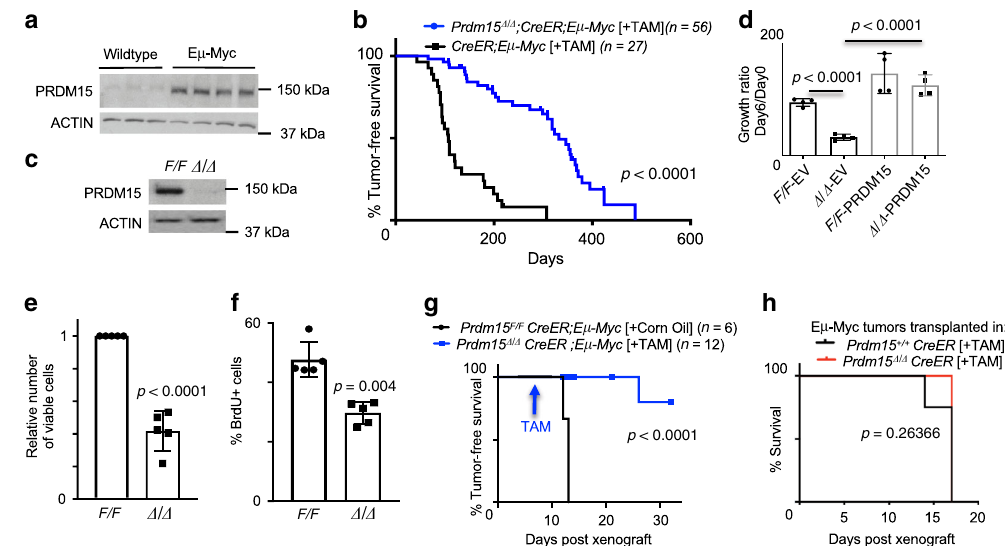
Fig. 3 PRDM15 is critical for lymphoma initiation and maintenance in E µ -Myc mice. a PRDM15 protein expression in bone marrow-derived B cells from wildtype ( n = 3) and E µ -Myc ( n = 4) mice. b Disease-free survival of R26; E µ -Myc or Prdm15 F/F ; R26; E µ -Myc mice injected with TAM at 5 weeks of age. c Western blot validation of complete PRDM15 protein depletion upon addition of 4-OHT (OHT) to Prdm15 F/F Rosa26Cre-ERT2 tumor cells cultured in vitro; data are from a representative experiment ( n = 20). d Growth ratio of Prdm15 F/F ;R26; E µ -Myc vs. Prdm15 Δ / Δ ;R26; E µ -Myc cells on day 6 post seeding. Cells were treated with 4-OHT (OHT) overnight (day − 1) to induce PRDM15 deletion ( Δ / Δ ). Prior to the addition of OHT, cells were transfected either with empty vector control (EV) or a vector expressing PRMD15 as indicated. Data are from two independent cell cultures, with two technical replicates each. Center values mean; error bars, s.d. e Relative number of viable E µ -Myc cells following PRDM15 depletion by OHT. f Relative % of Brdu + E µ -Myc cells upon EtOH ( Prdm15 F/F ) vs. OHT ( Prdm15 Δ / Δ ) treatment. In e and f , data are from independent primary lines ( n = 5). Center values, mean; error bars, s.d. g Overall tumor-free survival of mice transplanted with Prdm15 F/F ;CreER; E µ -Myc lymphoma cells, then injected with corn oil or TAM 1 week later. h Overall tumor-free survival of mice transplanted with E µ -Myc lymphoma cells. The background of the recipient mice was either WT ( Prdm15 + / + ;CreER ) ( n = 4) or Prdm15 null ( Prdm15 F/F ;CreER ) ( n = 5). Recipient mice were systemically depleted of PRDM15, using TAM, 2 weeks prior to reconstitution with lymphoma cells. In panel d – f , Student ’ s t test (two-sided) was used for statistical analysis. In panels b , g , and h , log-rank test was used to determine statistical signi fi